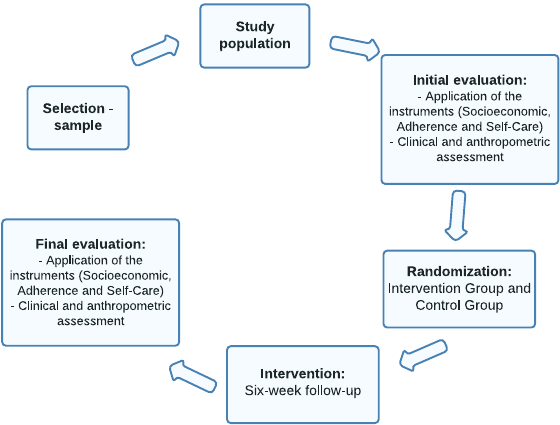
Figure 13. Evaluation scheme by LHA